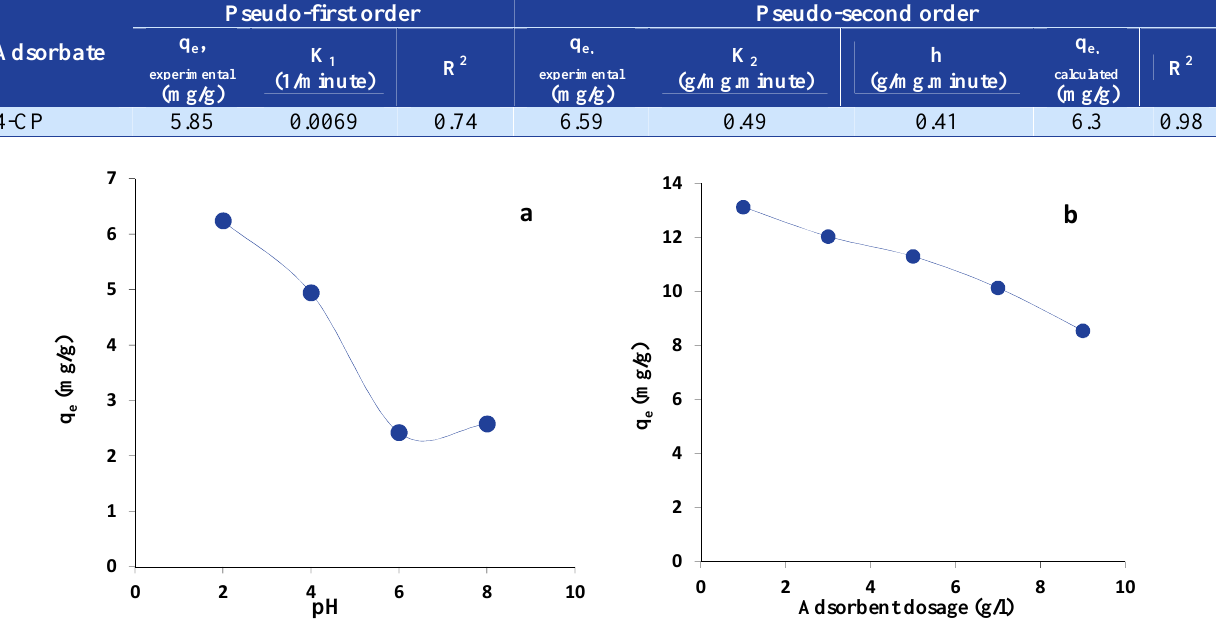
Figure 3. (a) Effect of pH on the adsorption of 4-CP (contact time = 40 minutes, adsorption dosage = 3 g/l, and initial concentration = 20 mg/l) and (b) effect of adsorbent dosage on the adsorption of 4-CP (contact time = 40 minutes, initial concentration = 20 mg/l, and pH =